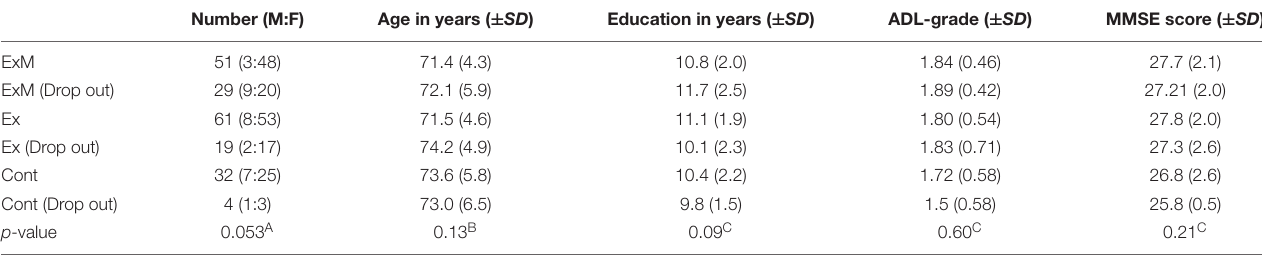
TABLE 1A | Baseline demographic